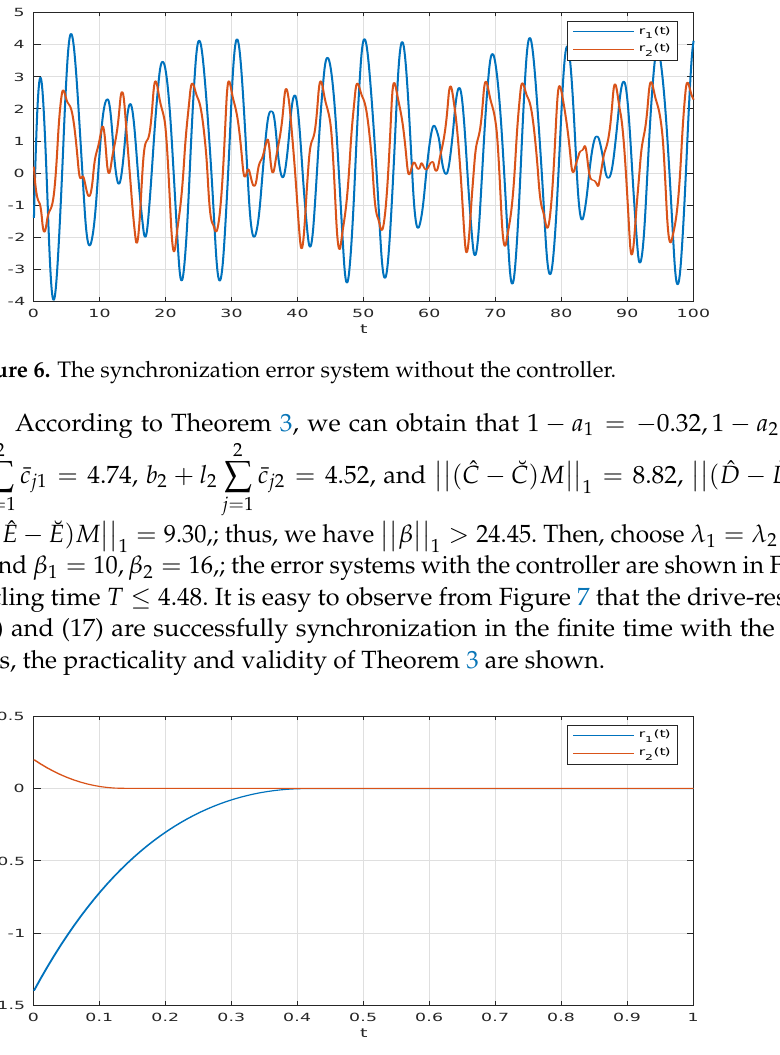
Figure 7. The synchronization error system with the